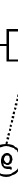
Figure 3. The role participation